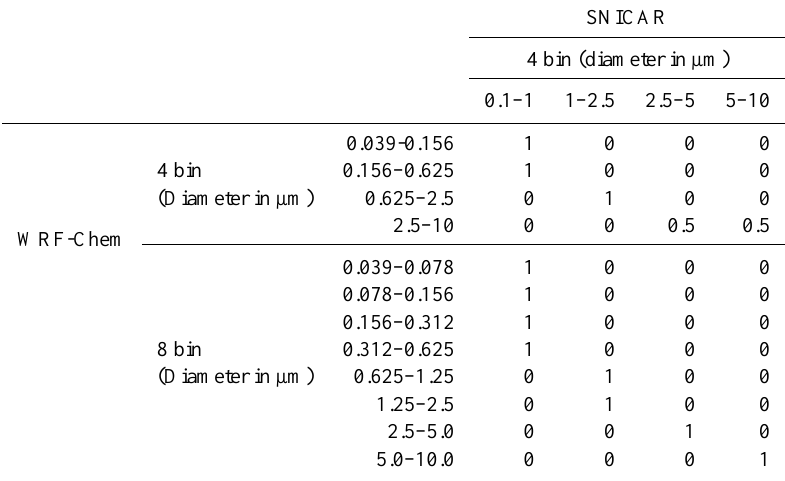
Table 1. Matching of dust size distributions between WRF-Chem and SNICAR. The values represent mass fractions of deposited atmospheric dust from WRF-Chem into each size of dust in snow in